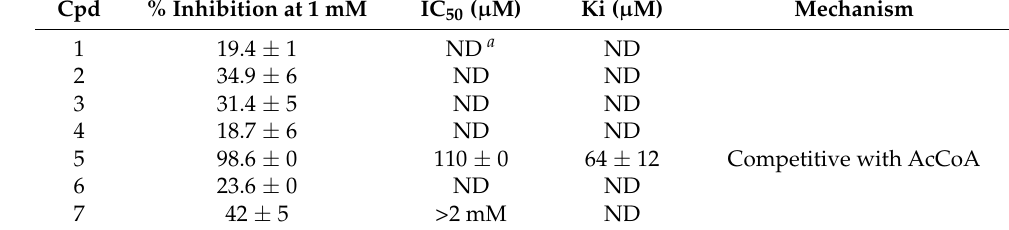
Table 1. Inhibition of SAT by compounds identified in the virtual screening.